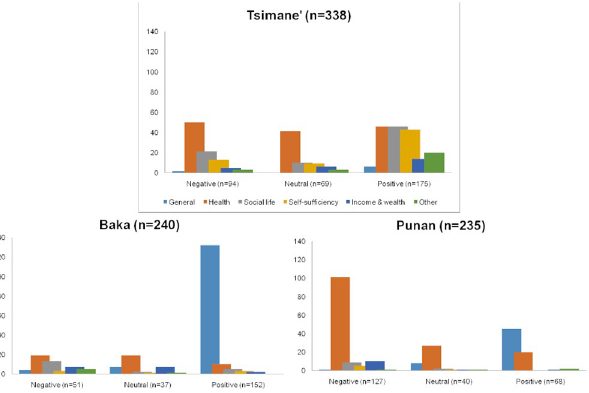
Fig 5. Reasons explaining life satisfaction scores, by life satisfaction level and society. Tsimane’ n = 338; Baka n = 240; Punan n = 235.